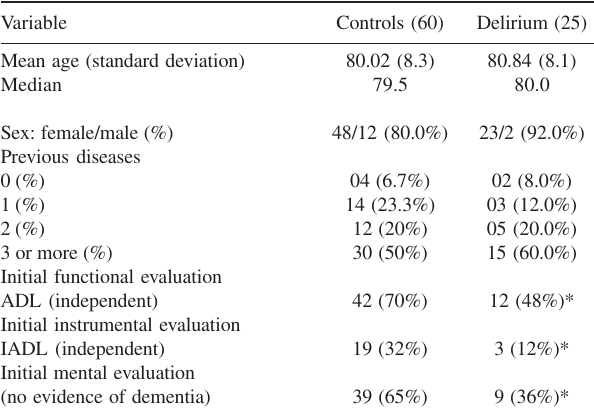
Table 1 - Sample characteristics